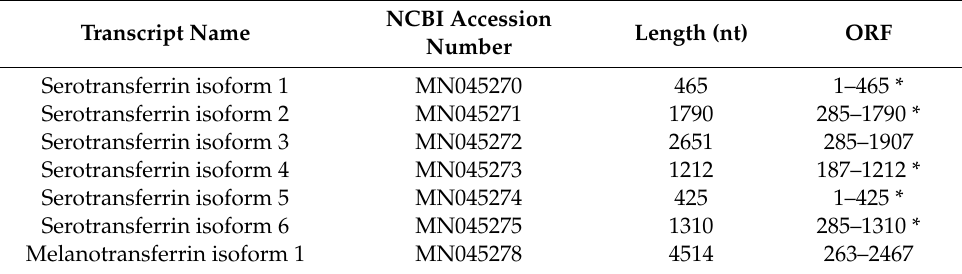
Table 1. List of identified genes and their isoforms in the sterlet together with their NCBI accession numbers. * incomplete ORFs.